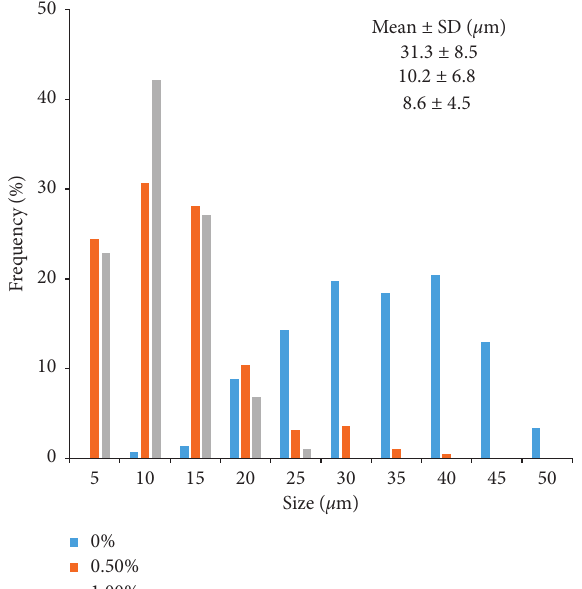
Figure 5: Influence of Tween 80 concentration on the size dis- tribution of HKG-gelatin complex particles.